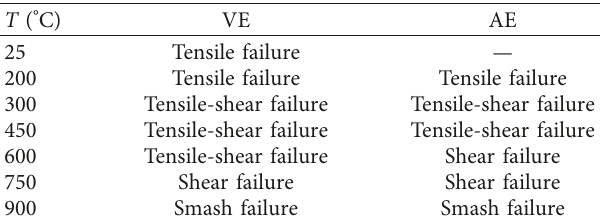
Figure 5: Four failure modes of marble specimens after heat treatment under uniaxial compression: (a) tensile failure, (b) tensile-shear failure, (c) shear failure, and (d) smash failure. Table 1: Effect of temperature and thermal environment on the failure modes of marble